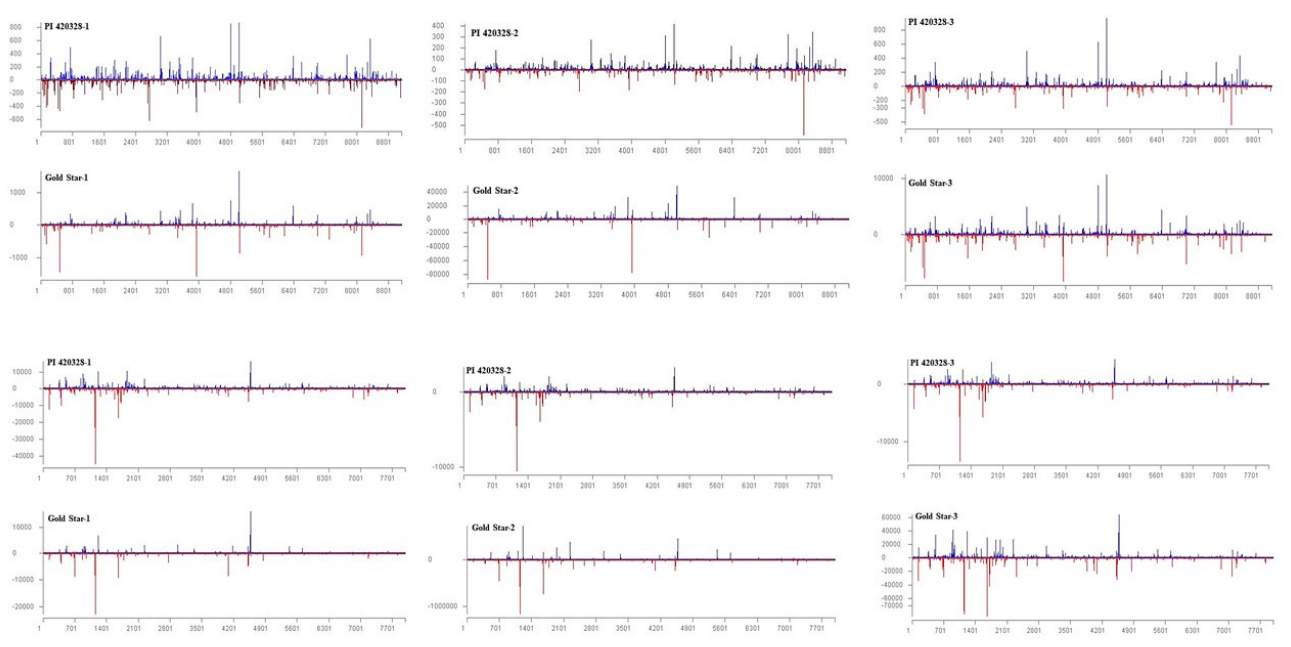
Figure 3. Distribution of vsRNAs along the genomes of CYSDV in PI 420328 and Gold Star 30 days after inoculation with cucurbit yellow stunting disorder virus (CYSDV). The histograms plot the numbers of 21 to 24 nt viral siRNA reads at each nucleotide position of CYSDV genomic RNA 1 and RNA 2, (mapped with zero mismatches). The bars above the axis (blue) represent sense (forward) reads starting at each position, and those below (red) represent antisense (reverse) reads ending at the respective position.